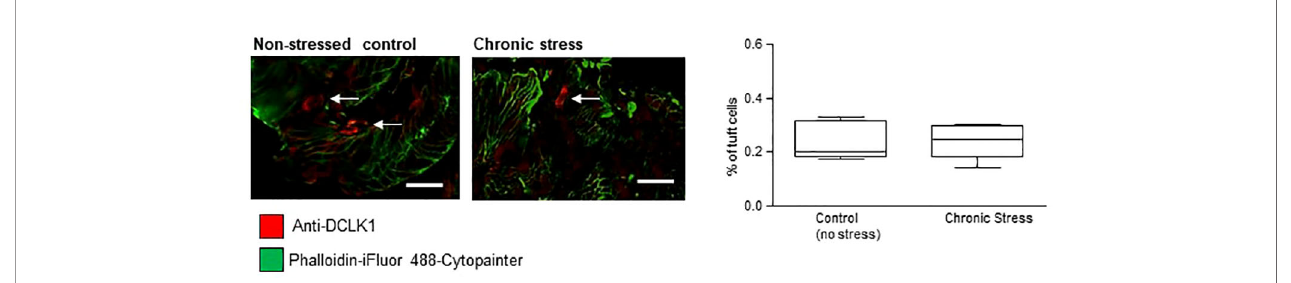
FIGURE 3 | Tuft cell density is not altered by chronic stress. The representative immuno fl uorescent images and box and whisker plots of pooled data show the density of DCLK1-labeled tuft cells as a percentage of the total DAPI-stained epithelial cells. No difference in the density of tuft cells was detected in colonic samples from mice which had undergone chronic stress. Scalebar: